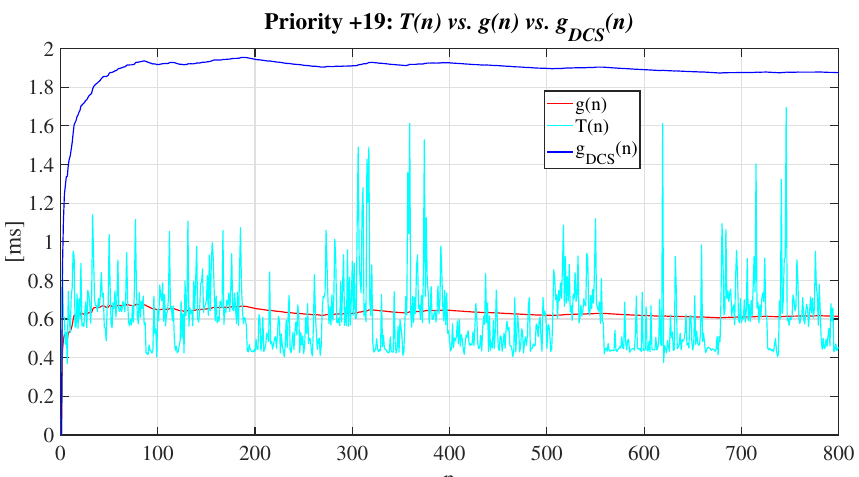
Figure 15. Temporary computational complexity analysis of the real-time quadrotor simulation algorithm using priority 19.